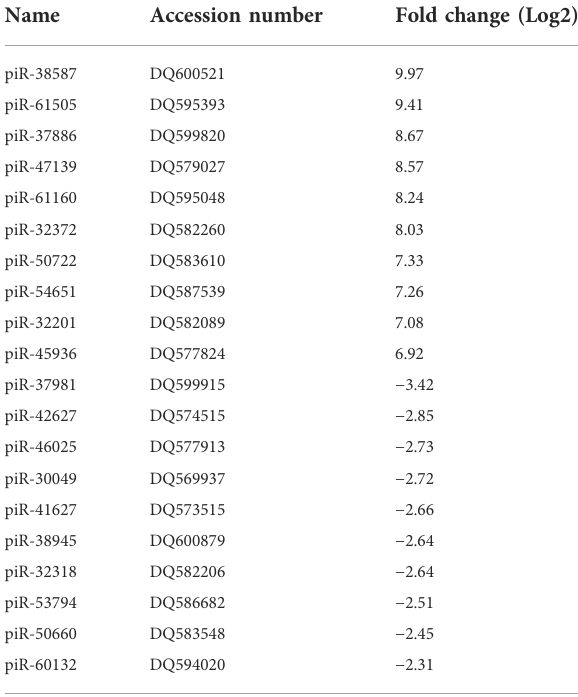
TABLE 3 Top 10 highly up- ( ≥ 4 fold) and down-regulated ( ≤ 4 fold) piRNAs by RSV 24 h p.i. ( p ≤ 0.01). DQ is the accession number of piRNA in the NCBI database.